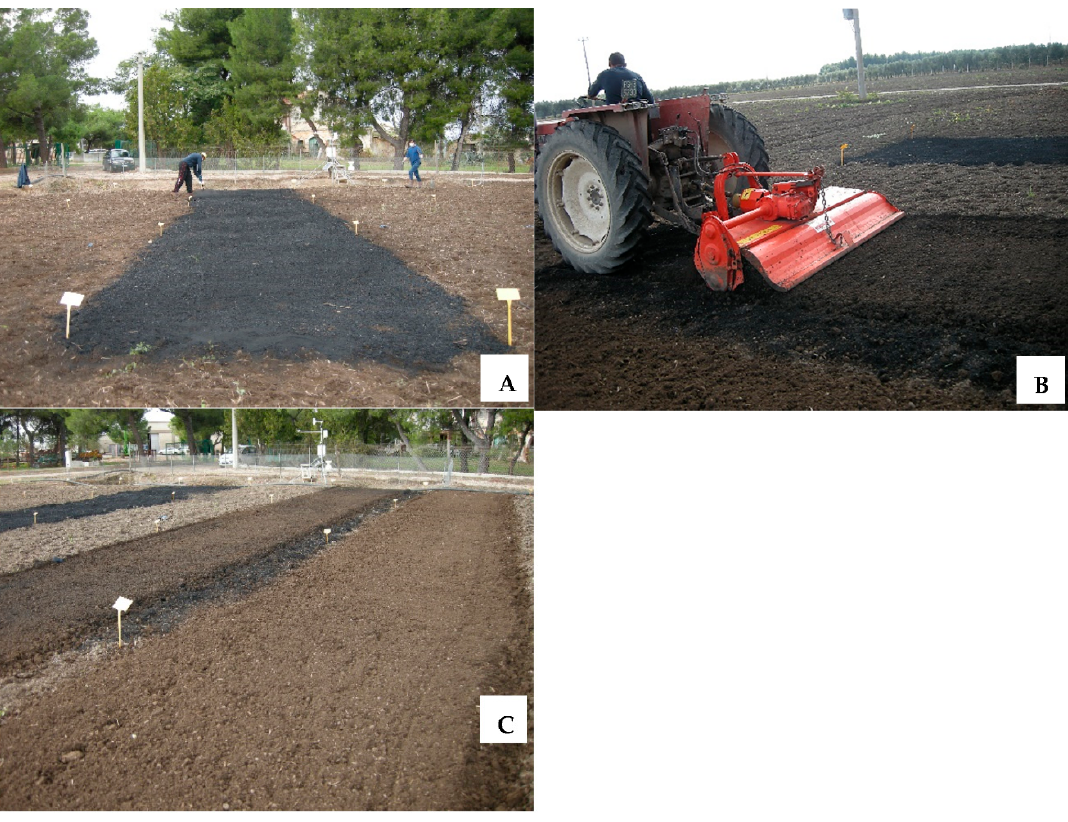
Figure A1. Sequential operations of biochar application to soil: ( A ) Biochar broadcasting at the soil surface through a fertilizer spreader 1 month before the first transplanting; ( B ) biochar mixing within the upper 0.20 m of soil layer with a rotary hoeing tillage; ( C ) final resulting soil preparation.